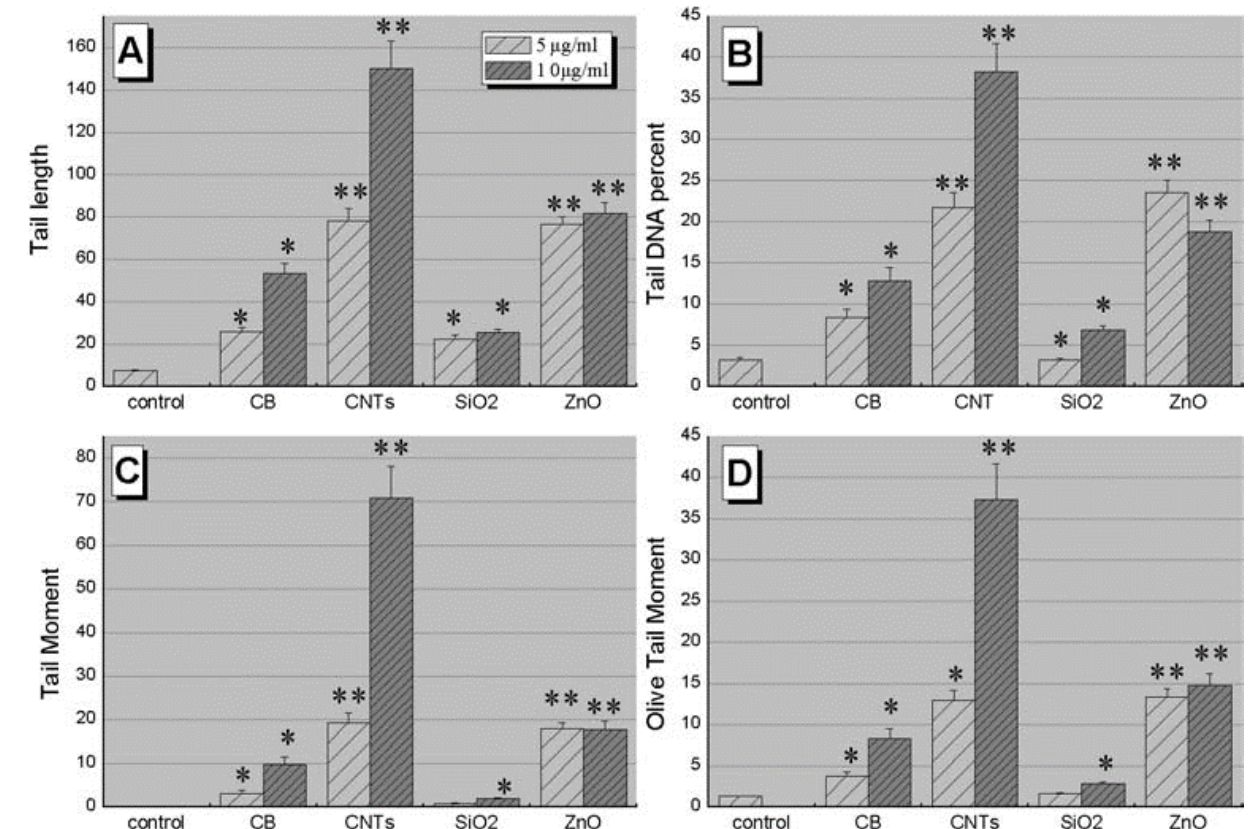
Figure 14. DNA damage determined by comet assay in PMEF cells exposed to NPs. Cells were respectively treated with 5 µ g mL − 1 of CB, CNT, SiO 2 , and ZnO for one day. Damage was evaluated by ( A ) tail length, ( B ) tail DNA, ( C ) tail moment, ( D ) Olive tail moment. Values shown are the mean from 50 images. * p < 0.05; ** p < 0.01 in comparison to blank. Adapted from Ref. [121], copyright 2009, with permission from Wiley & Sons,